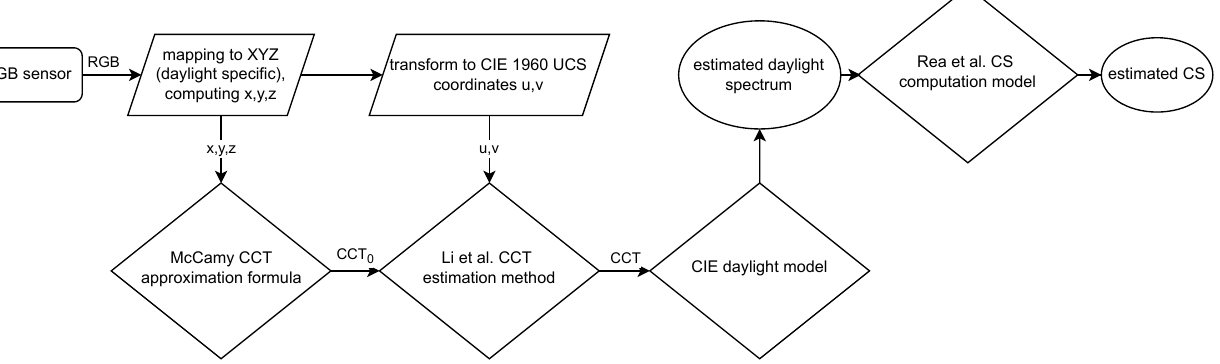
Figure 13. CS estimation from RGB sensor responses for daylight light sources. A daylight-specific 3 × 3 transformation matrix is used to map RGB sensor responses to XYZ tristimulus values. Mc- Camy’s CCT approximation (Equation (16)) gives a starting point CCT 0 for Li et al.’s CCT estimation method. The resulting CCT is used as the input for the CIE daylight model (Equations (9)–(14)) to estimate the daylight spectrum. Finally, Rea et al.’s original CS computation model is applied to the estimated daylight